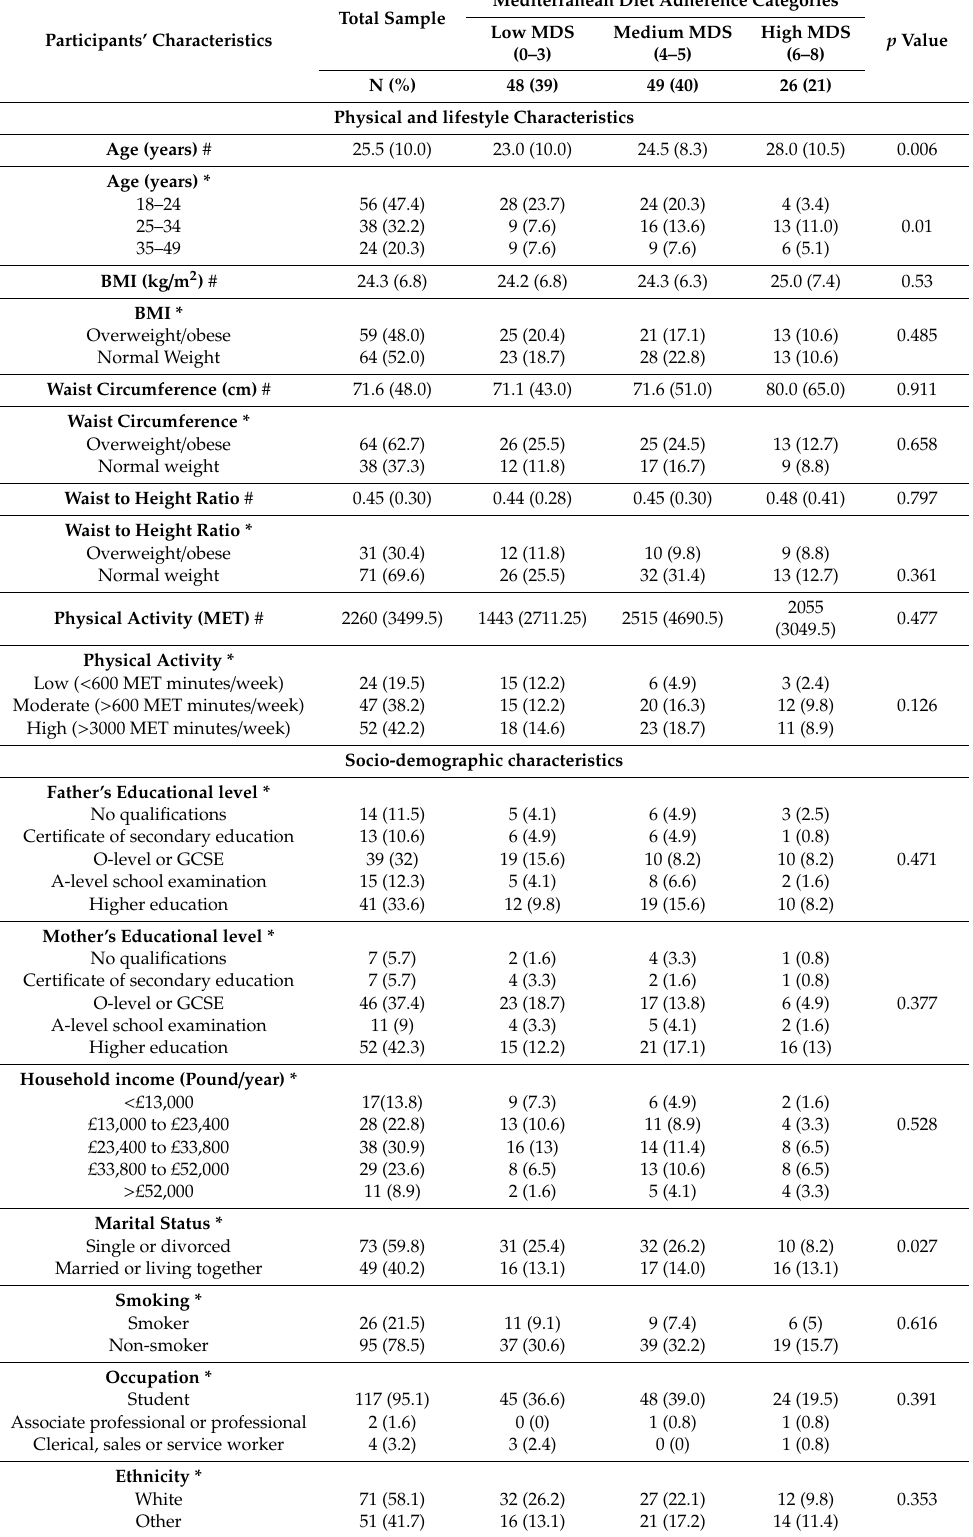
Table 1. Socio-demographic and physical characteristics of participants ( n =